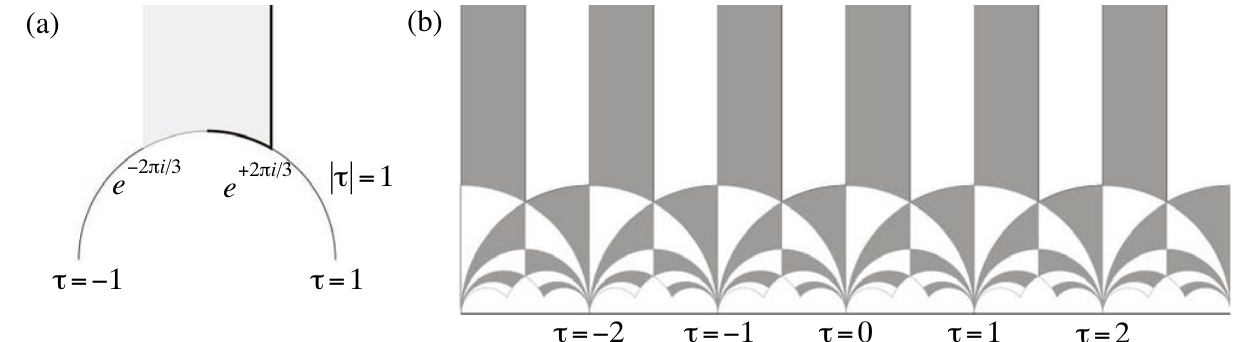
Figure 2. (a) The shaded region shows the fundamental set 𝕄 for the modular group. We include only the right half of the boundary, that is, boundary points with 0 ≤ Re ≤ { τ } ≤ ½, shown as a dark curve. There are no modular transformations connecting any pair of distinct points in 𝕄 . (b) The images of the fundamental set 𝕄 under the modular group tessellate the plane. We have shaded the right half of 𝕄 and all its images, while the left half of 𝕄 and all its images are left white, though their boundaries are drawn in gray. The images of 𝕄 shown here were obtained from those modular transformations with a = 0, b = –1, c = 1 and –2 ≤ d ≤ 2 (corresponding to τ' = τ + d , followed by τ'' = –1/ τ' ), or these transformations followed by a translation. The region close to the real axis is progressively filled as further transforma- tions of 𝕄 are considered, but it become increasingly hard to portray the images without increasing the magnification of the